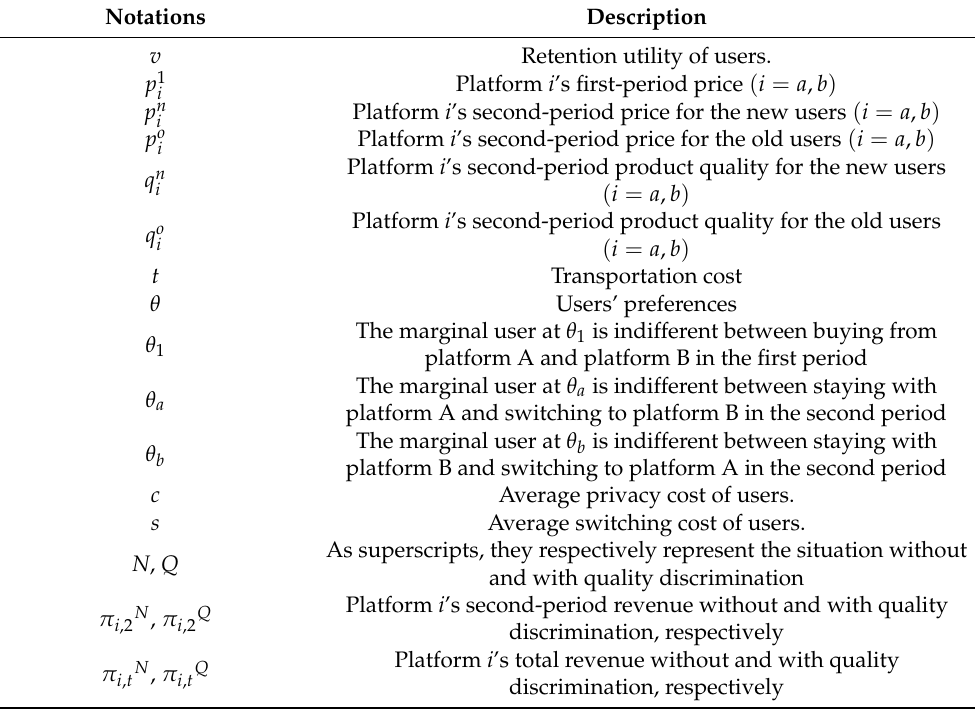
Table 1. Summary of